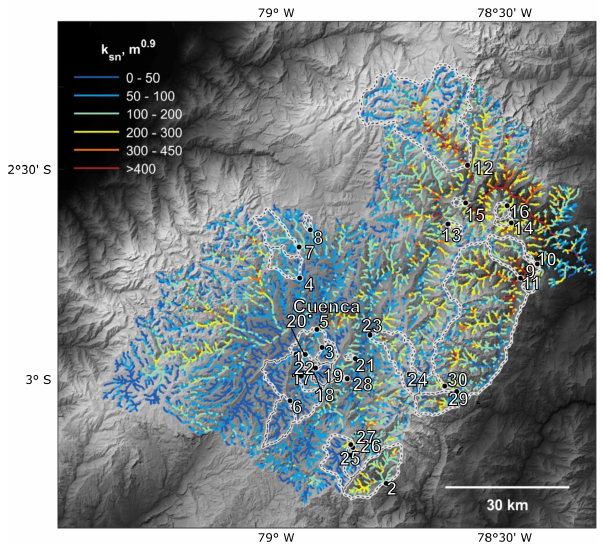
Figure 5. Calibration of the precipitation ( P ) versus runoff curve ( R ). Mean annual runoff versus the mean annual precipitation for all WaterGAP3 pixels in Ecuador (0.25 ◦ ; 1979–2014; WaterGAP3 data available from